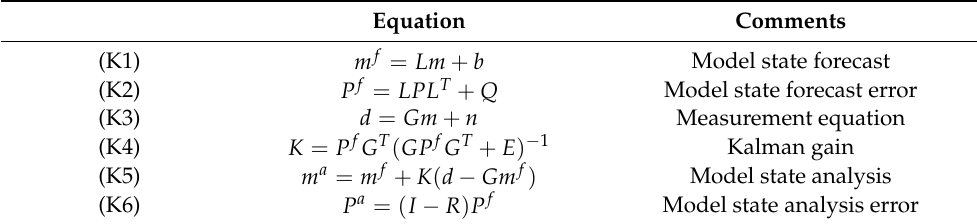
Table 1. The Kalman filtering